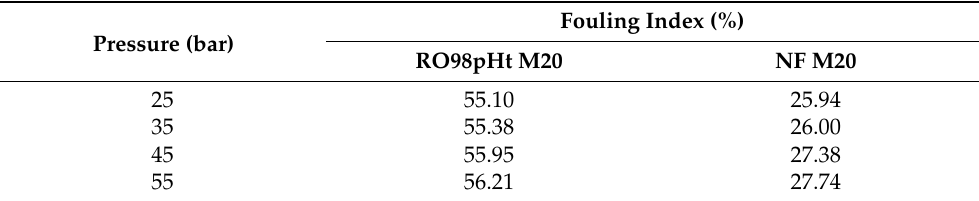
Table 1. Fouling index (%) of reverse osmosis (RO) and nanofiltration (NF) membranes at four different pressures.